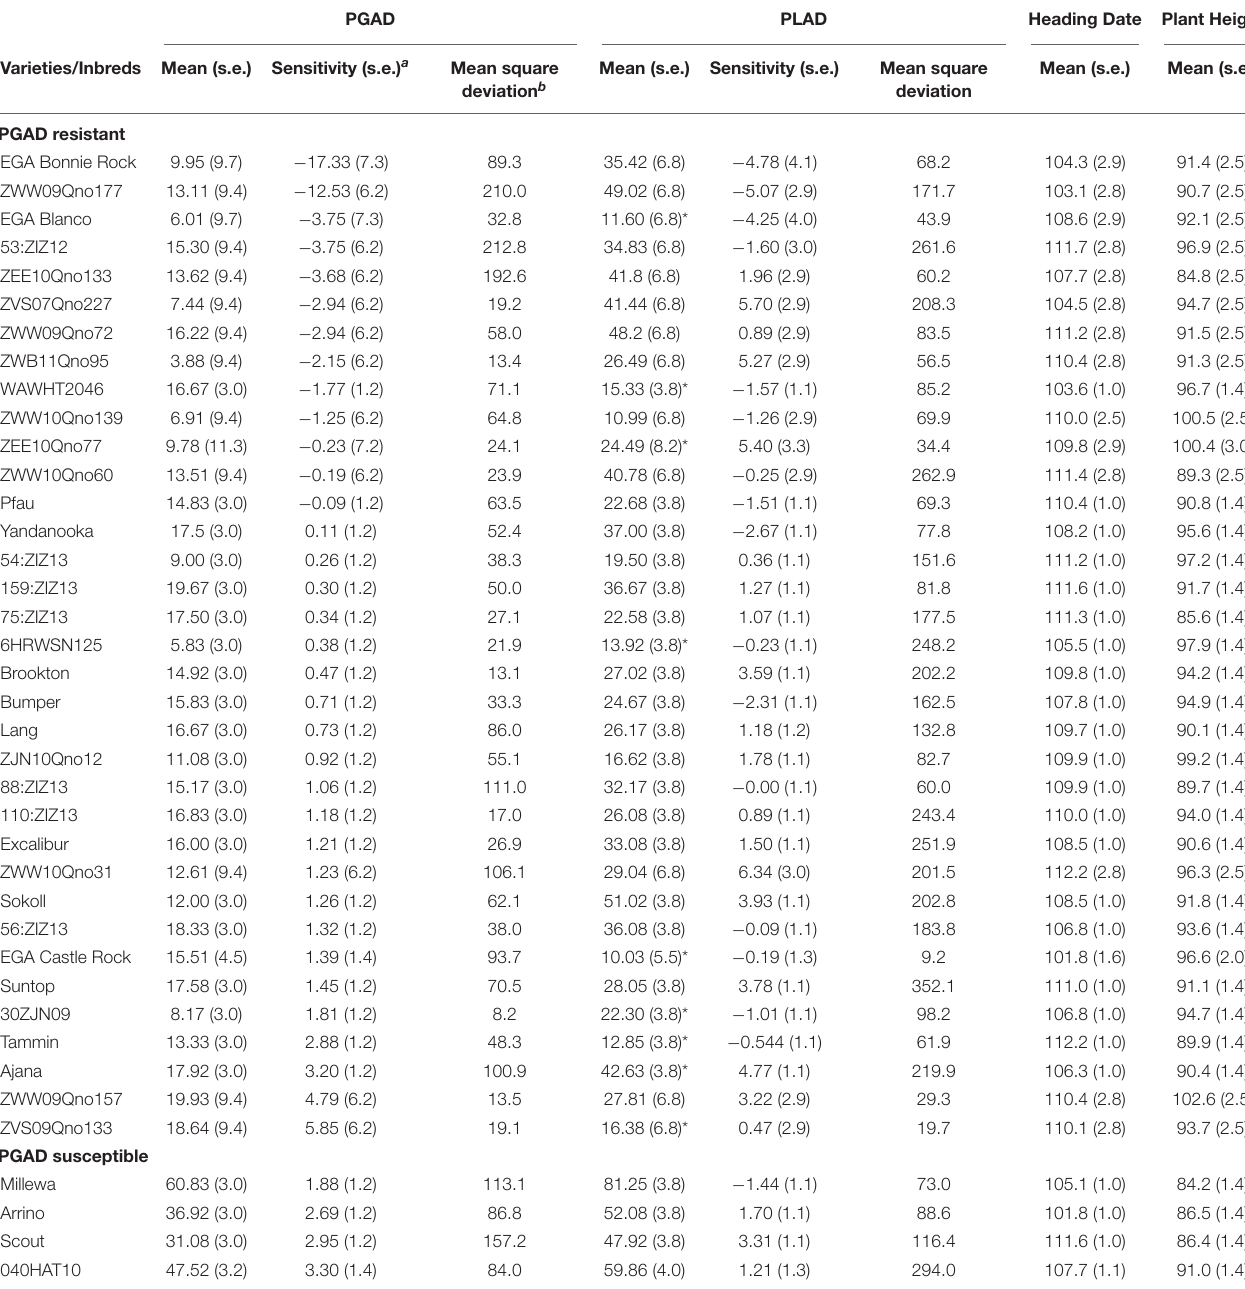
TABLE 6 | Assessment of wheat lines using Finlay-Wilkinson joint regression for low mean PGAD scores ( < 20%) and stability across four WA environments with corresponding PLAD scores, heading date and plant height compared with control susceptible lines in 2018–2020. PGAD PLAD Heading Date Plant